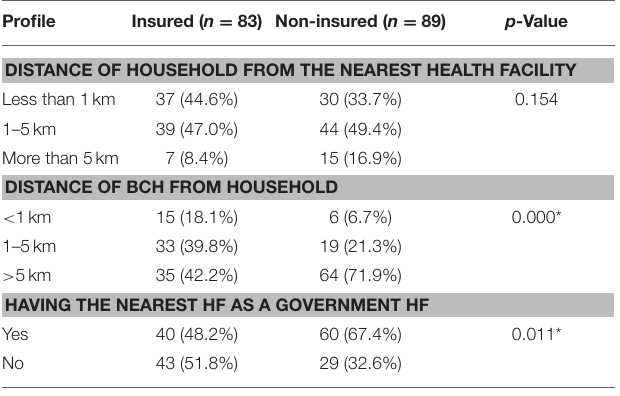
TABLE 11 | Severity of illness of the children of the